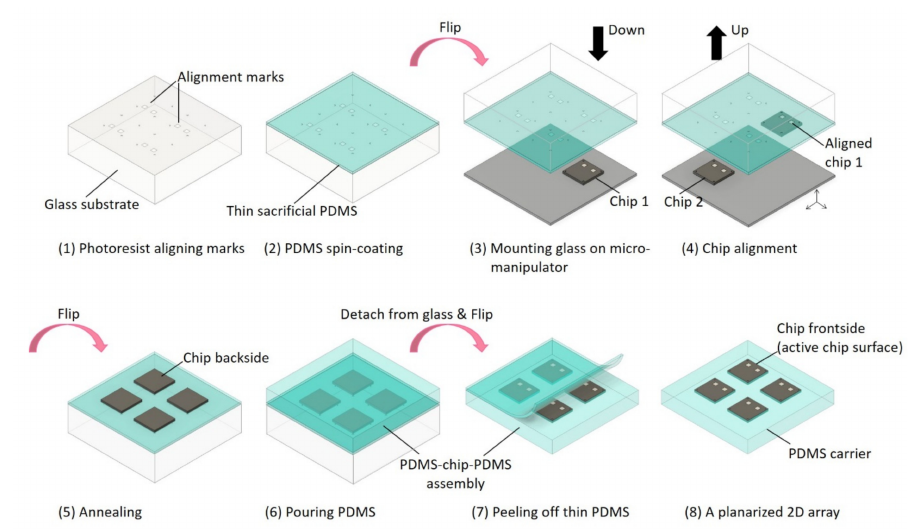
Figure 1. The polydimethylsiloxane (PDMS)-based fabrication procedures for 2D-planarized chip arrays for post-processing: ( 1 ) A patterned array of photoresist aligning marks is created on a glass substrate. ( 2 ) The glass substrate is spin-coated with the first 65 µ m-thick PDMS layer. ( 3 ) After baking, the glass substrate is mounted on a manipulator with the adhesive PDMS layer facing down. ( 4 ) The chips are aligned and picked up by the sticky PDMS surface, guided by the markers. ( 5 ) The glass substrate with the chips is detached from the manipulator and annealed. ( 6 ) With the glass substrate facing down, the second layer of planarizing PDMS is poured over the chips and cured overnight. ( 7 ) After detaching the glass substrate, the spin-coated PDMS layer is carefully peeled away. ( 8 ) The complementary metal–oxide–semiconductor (CMOS) chip array with active circuits exposed and flushed with PDMS carrier is ready for post-process